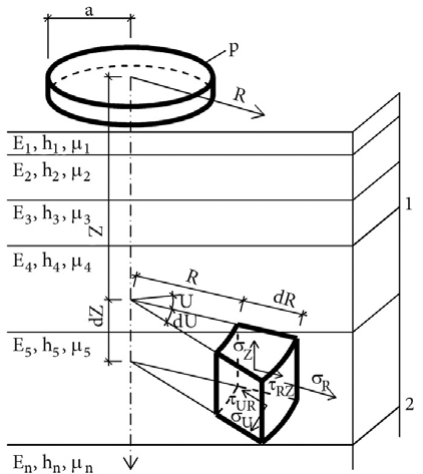
Fig. 10. Scheme of multi-layer linear elastic mathematical